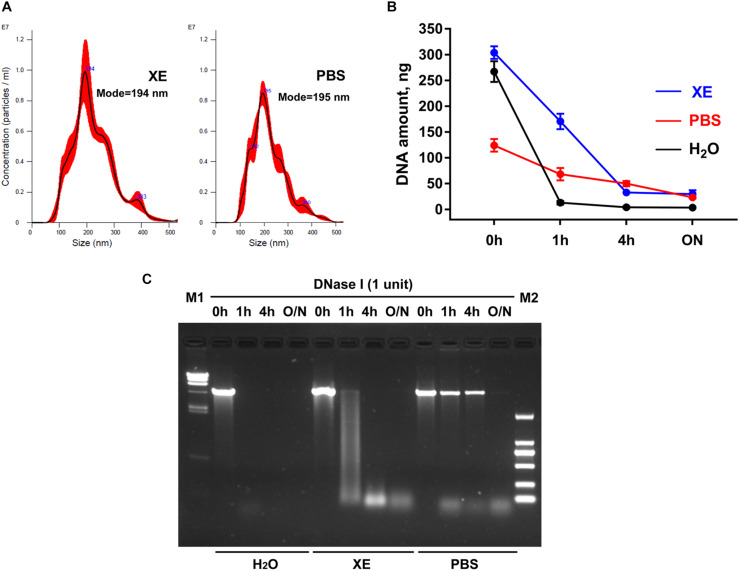
Effects of exosome resuspension buffers on subsequent DNA extraction. (A) NanoSight analysis for particle number and size distribution of exosomes suspended in PBS and Buffer XE. (B) Change of DNA content in three different solvents after DNase I digestion for the indicated time. The results were repeated for at least five times. (C) Agarose gel electrophoresis of plasmid DNA in three different solvents. M1, λ-HindIII digest DNA marker; M2, DL2000 DNA marker; O/N, overnight.